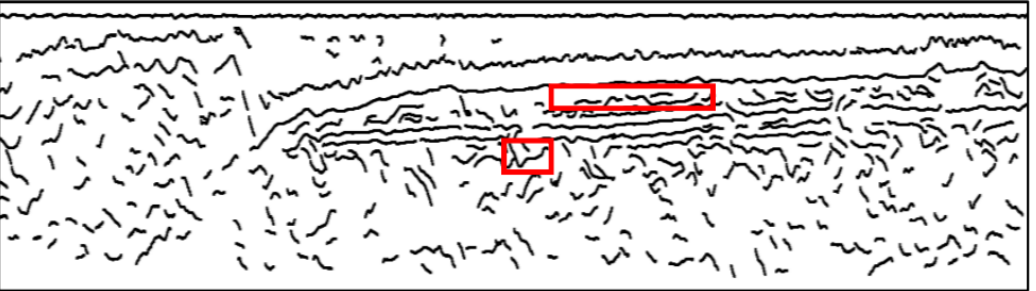
Figure 12. The detailed horizons obtained without enhancement filtering. Red rectangles show the discrete and wrong horizons.